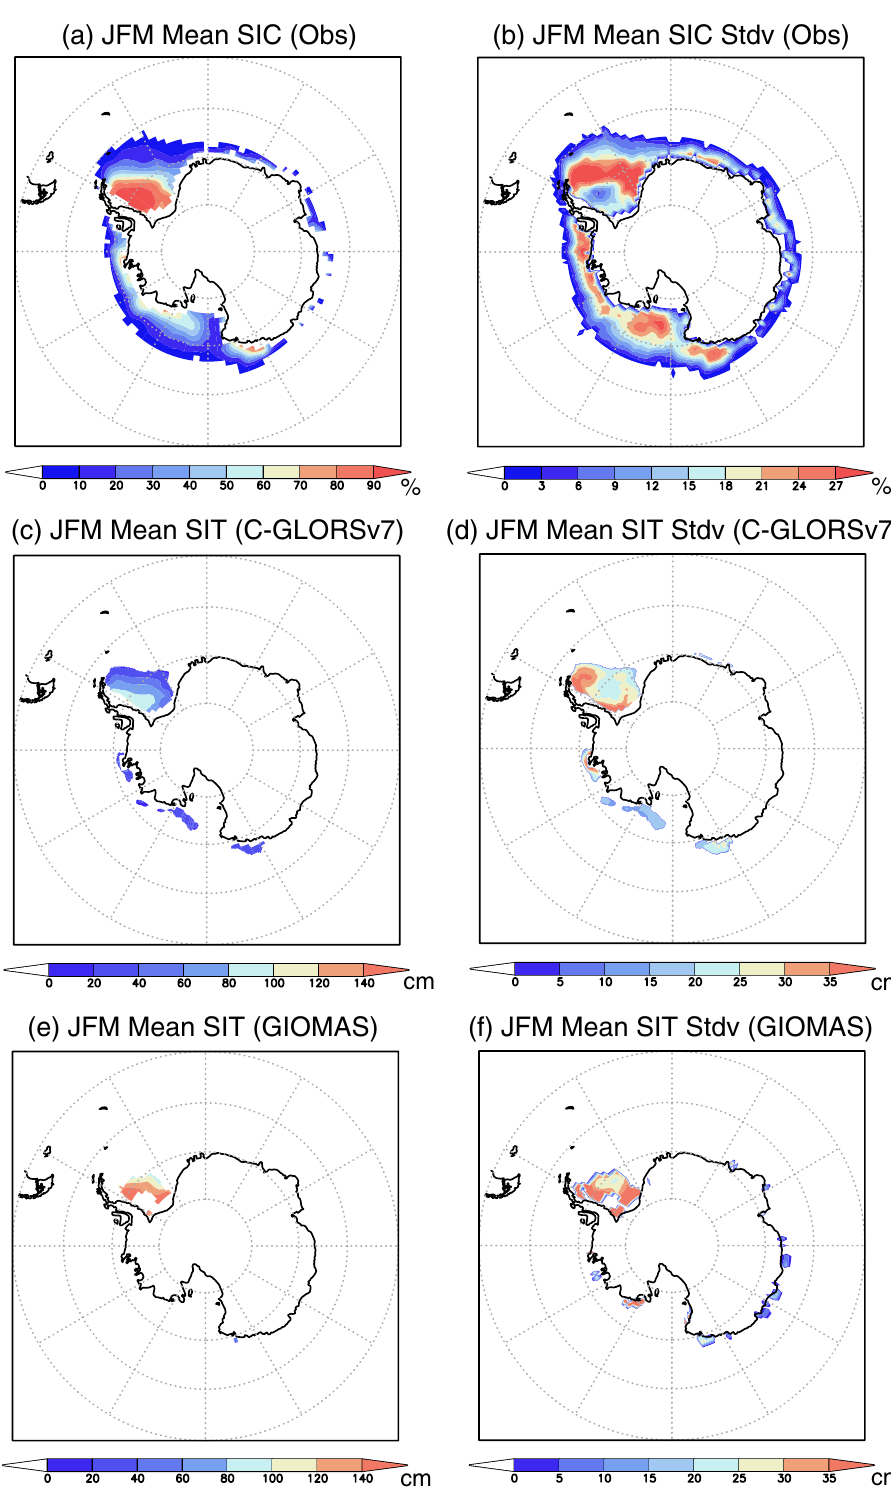
Figure 1. ( a ) Antarctic sea-ice concentration (SIC in %) during austral late summer-early autumn (January– March) from the OISSTv2 data. ( b ) Same as in ( a ), but for the standard deviation of the SIC (in %). ( c ) Antarctic sea-ice thickness (SIT in cm) during January–March from the C-GLORSv7 reanalysis. ( d ) Same as in ( c ), but for the standard deviation of the SIT (in cm). ( e , f ) Same as in ( c , d ), but from the GIOMAS